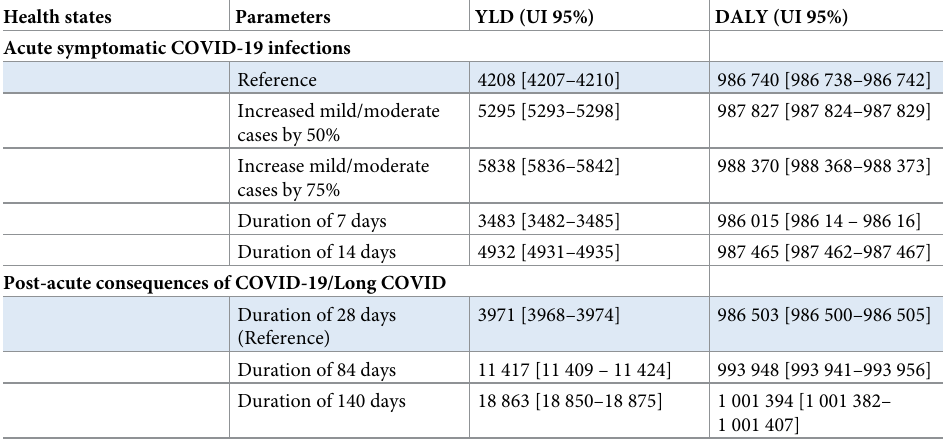
Fig 5. Scenario analyses highlighting the impact of infections and the durations on YLD, France, 2020. https://doi.org/10.1371/journal.pone.0280990.g005 (982 531) than in Germany (303 608) despite having a smaller poplulation size. Both countries had different mortality data sources (i.e., surveillance data on notifiable diseases in Germany and causes of death statistics in France). France recorded a higher number of infections and Table 2. Scenario analyses highlighting the impact of number of infections and the durations on YLD and DALYs, France,